Question: Write a single sentence explaining what this figure depicts.
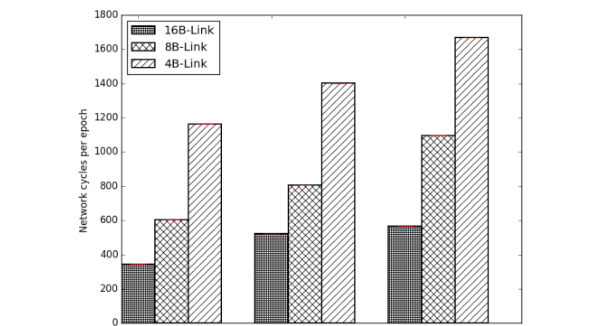
Answer: Number of clock cycles per input epoch for different